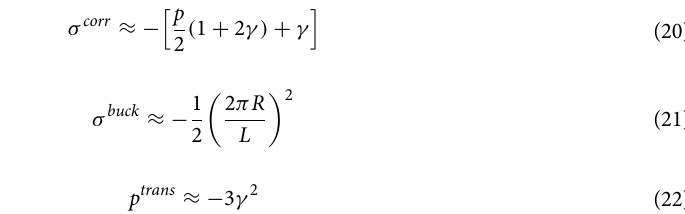
1 / 50 , which agrees with the observations in zebrafish embryo. In =